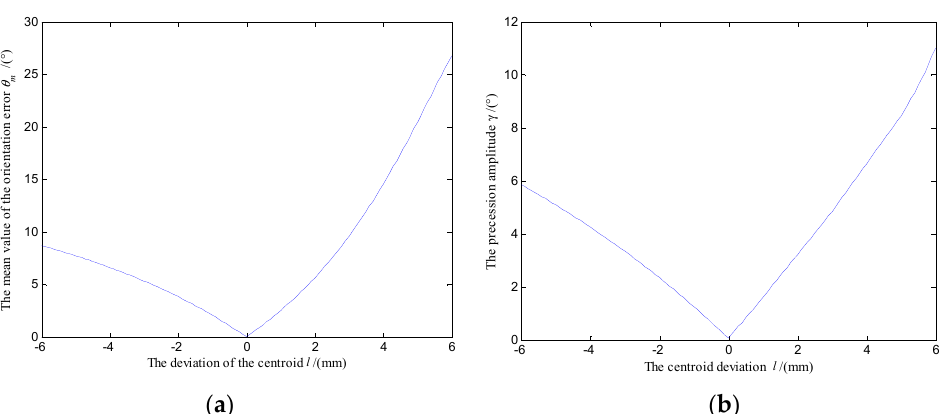
Figure 11. Variation law of the polar axis n f with the centroid deviation l . ( a ) Variation of orientation error θ m with centroid deviation l ; ( b ) Variation of precession amplitude γ with centroid deviation l .